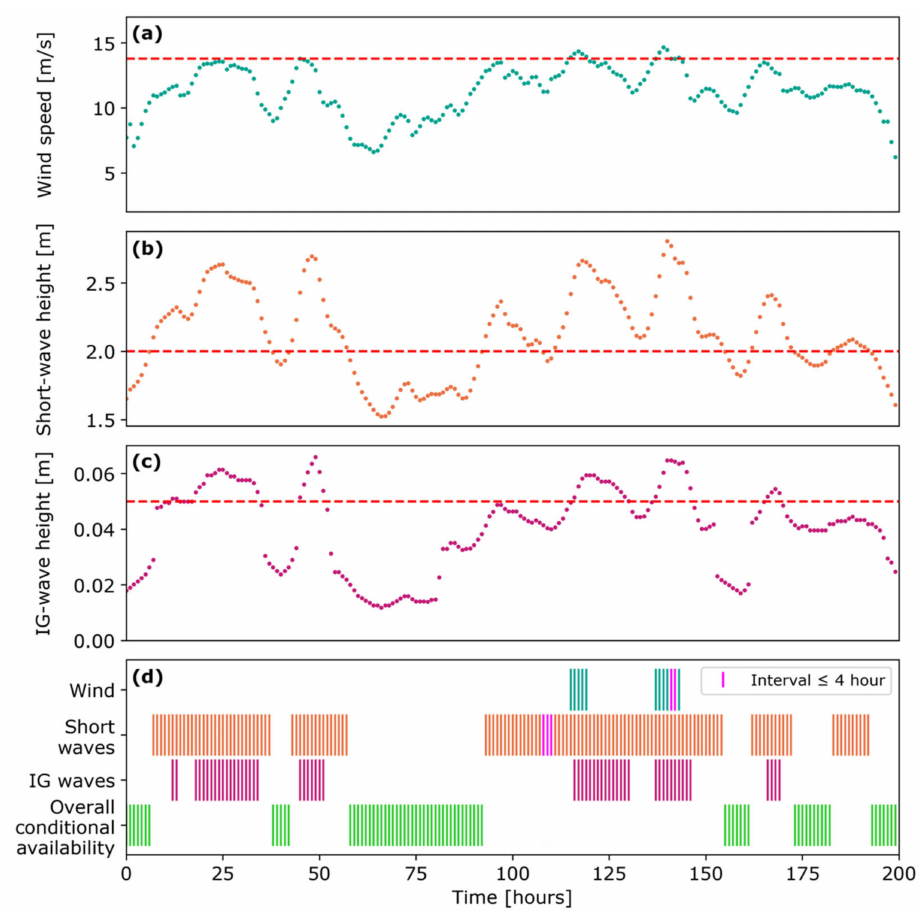
Figure 2. Schematic representation of the conditioned thresholding approach. The upper three panels show snapshots of the time series of the metocean indicators: ( a ) wind speed; ( b ) short wave height; and ( c ) IG wave height. The red-dashed lines represent the thresholds for each indicator. The lower panel ( d ) shows the resulting conditional unavailability for each indicator (cyan for wind, orange for short waves, purple for IG waves) and the overall remaining availability ( P total , in